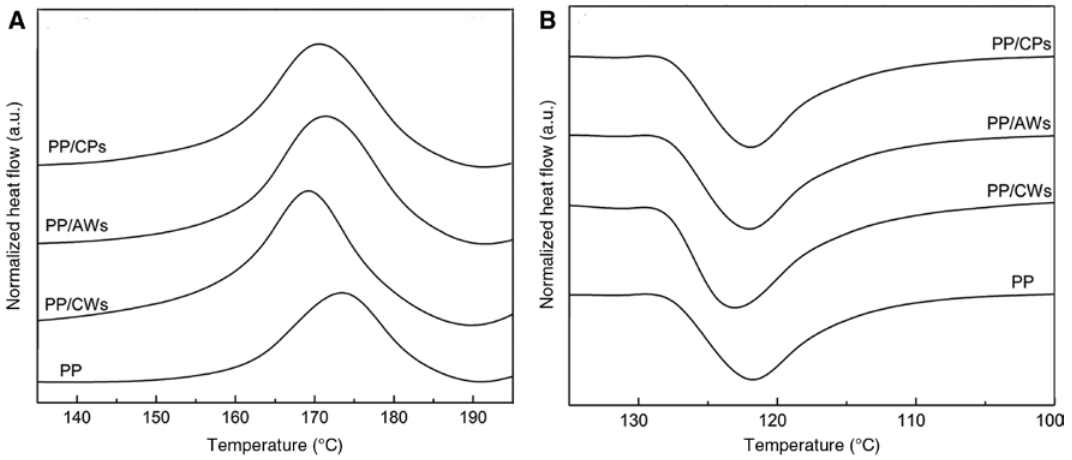
Figure 7: DSC thermograms portraying neat PP and composites reinforced with 5 wt% CWs, AWs, CPs (A) melting process, (B) crystallization process.